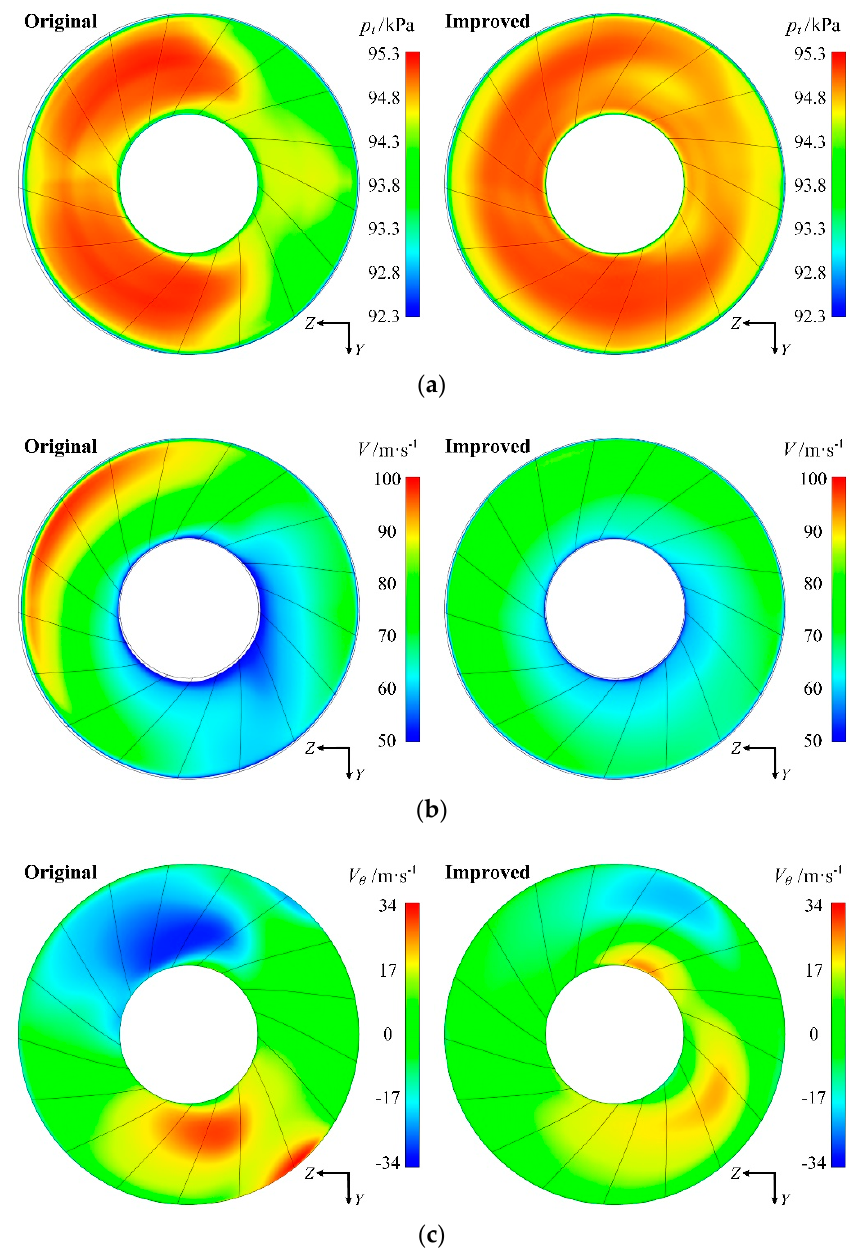
Figure 14. Flow contours at the impeller inlet. ( a ) Comparison of total pressures. ( b ) Comparison of velocity magnitudes. ( c ) Comparison of tangential velocities.